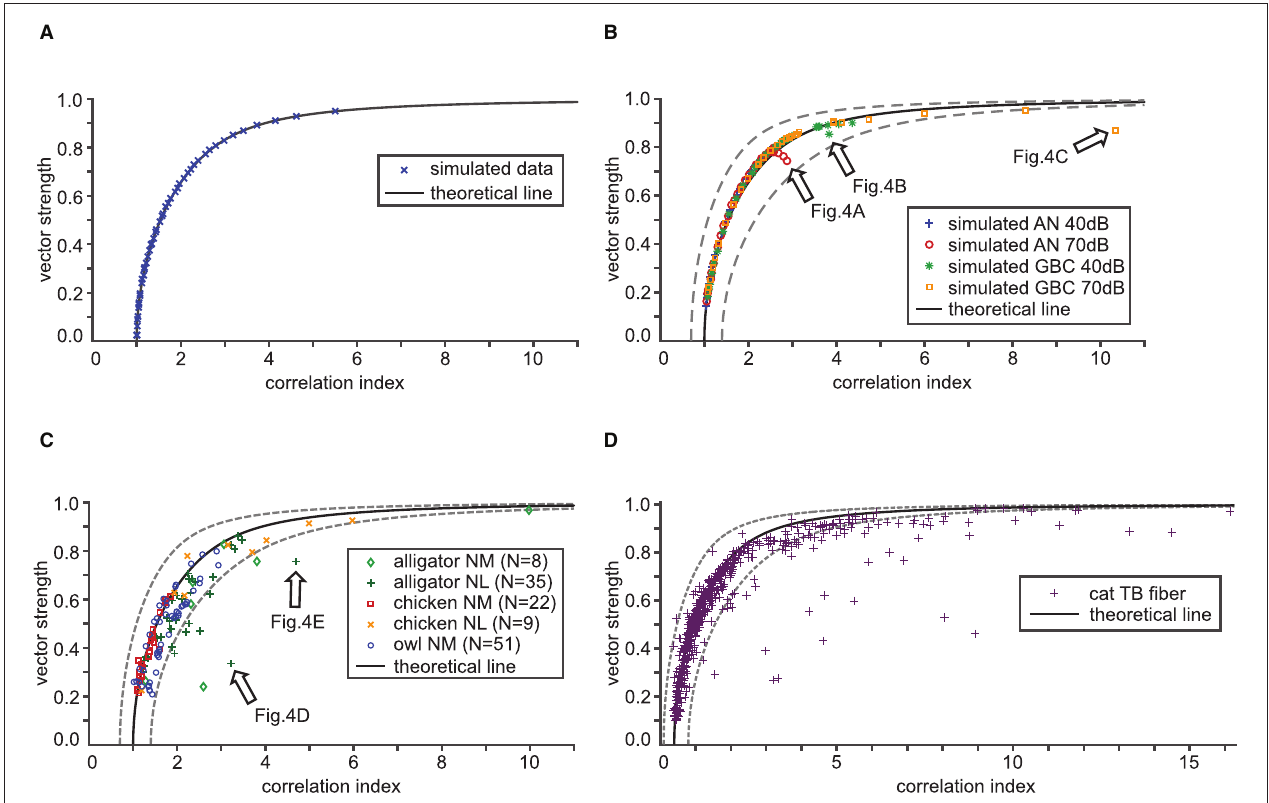
FIGURE 3 | Validation of the theoretical relation between VS and CI. In each panel, the theoretical VS-CI relationship is shown with a black solid curve, while simulated or recorded data are shown by different types of symbols. The gray dotted lines indicate 0.7 × (theoretical CI) and 1.4 × (theoretical CI) for each value of VS. (A) VS and CI values for numerically calculated von Mises distributions. Results from 46 simulated units that are locked at 500 Hz with target VS values ranging from 0.05 to 0.95 (in steps of 0.02) are shown. (B) Simulated auditory nerve (AN) and globular bushy cell (GBC) responses with 58 units each. The stimulus frequency was fixed to the unit’s CF that ranged from 200 to 2,000 Hz, each tested at 40 and 70 dB SPL. (C) VS-CI relationship from 125 auditory brainstem neurons of three animal species. (D) VS-CI relationship in 564 tonal responses of cat TB fibers. Data points were adapted from Joris et al. (2006) with permission. Arrows in (B,C) indicate the examples used in Figure 4